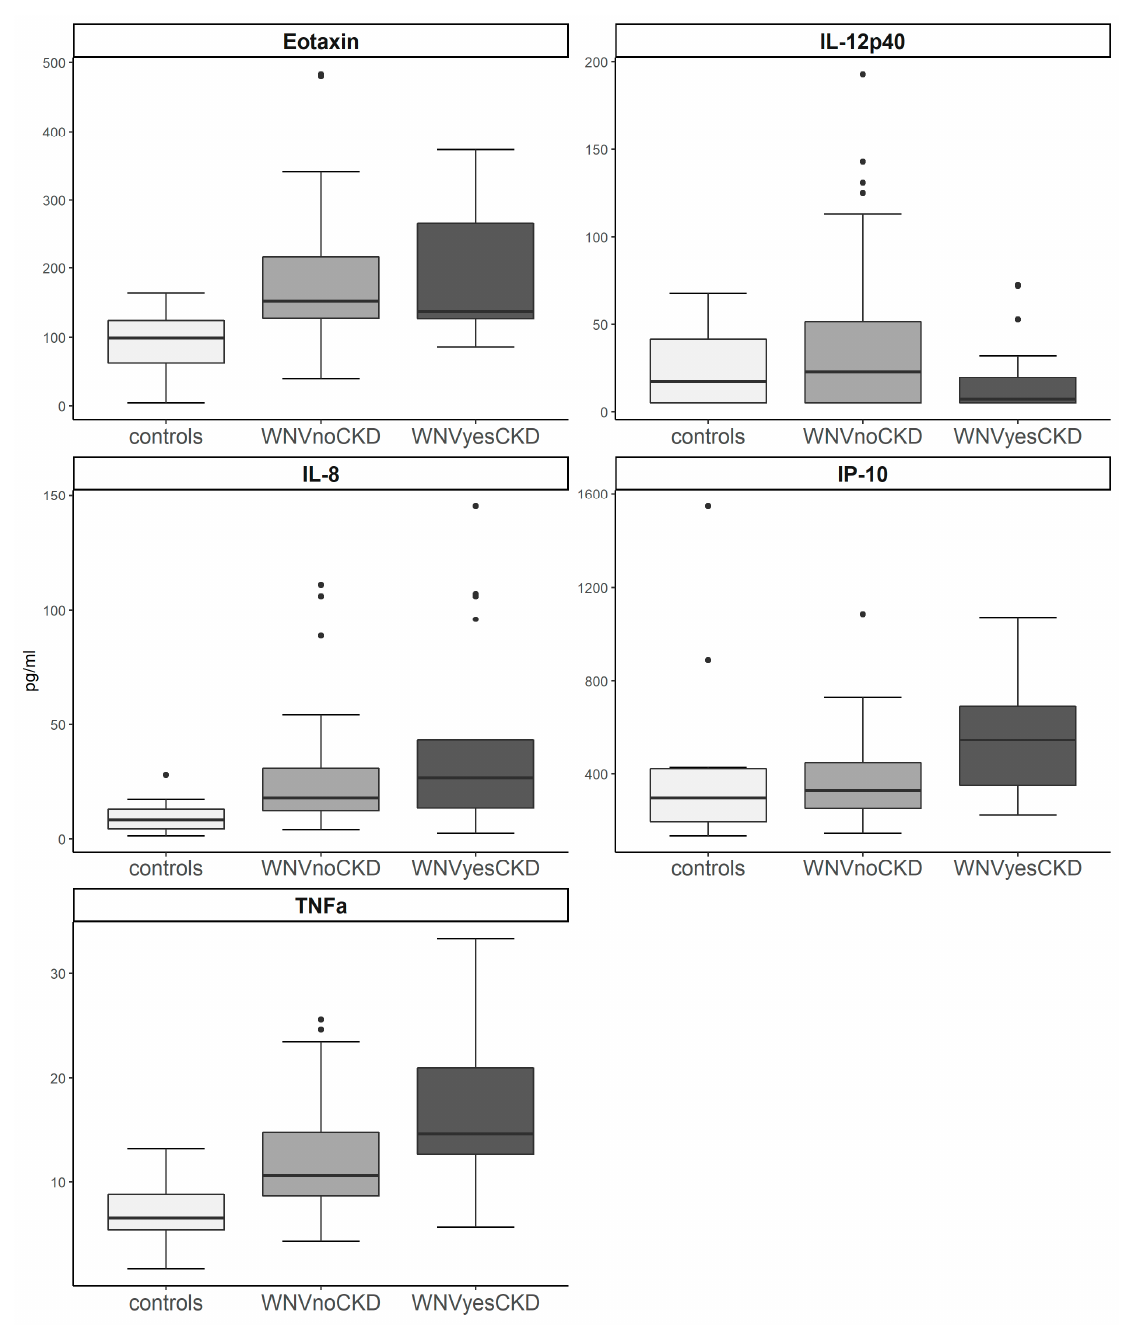
Results of analyses were adjusted for multiple inter-group comparisons using the Bonferroni correction. Abbreviations: WNV, West Nile virus; CKD, chronic kidney disease; IL, interleukin; IP-10, interferon gamma-induced protein 10; TNF, tumor necrosis factor.